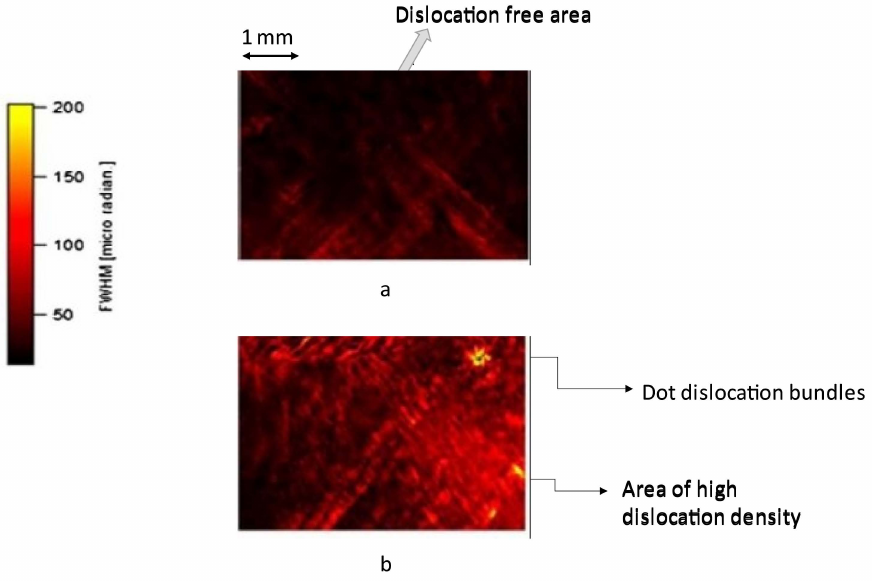
Figure 9. The rocking curve maps of two CVD single crystal diamond plates in (220) crystallographic planes; the part of the sample shown in ( a ) maybe of good crystallinity. However, even in this region the presence of dislocation bundles evident from coloured bands cannot be ruled out. The lower-half portion of the sample plate in ( a ) shows a high density of line dislocation evident from the thick lines. The sample in ( b ) shows a high density of dislocation aggregates. A dot-like structure full of dislocation bundles can also be seen in the upper-left corner of the image in ( b ). The size of the plates is approximately 5 mm × 4 mm. The image is taken from ref. [2]: Tarun, A.; Lee, S.J.;